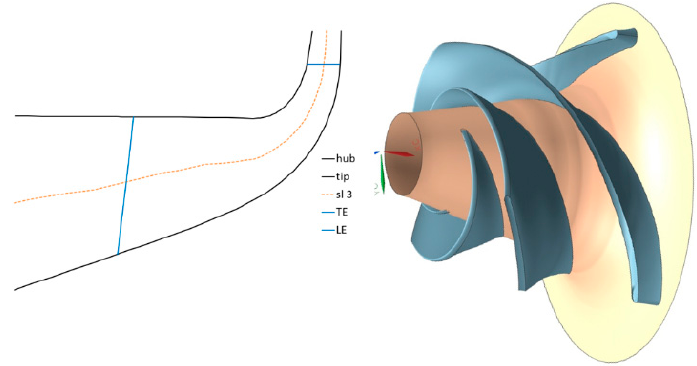
Figure 29. Representative turbopump generated with minimal parameters.